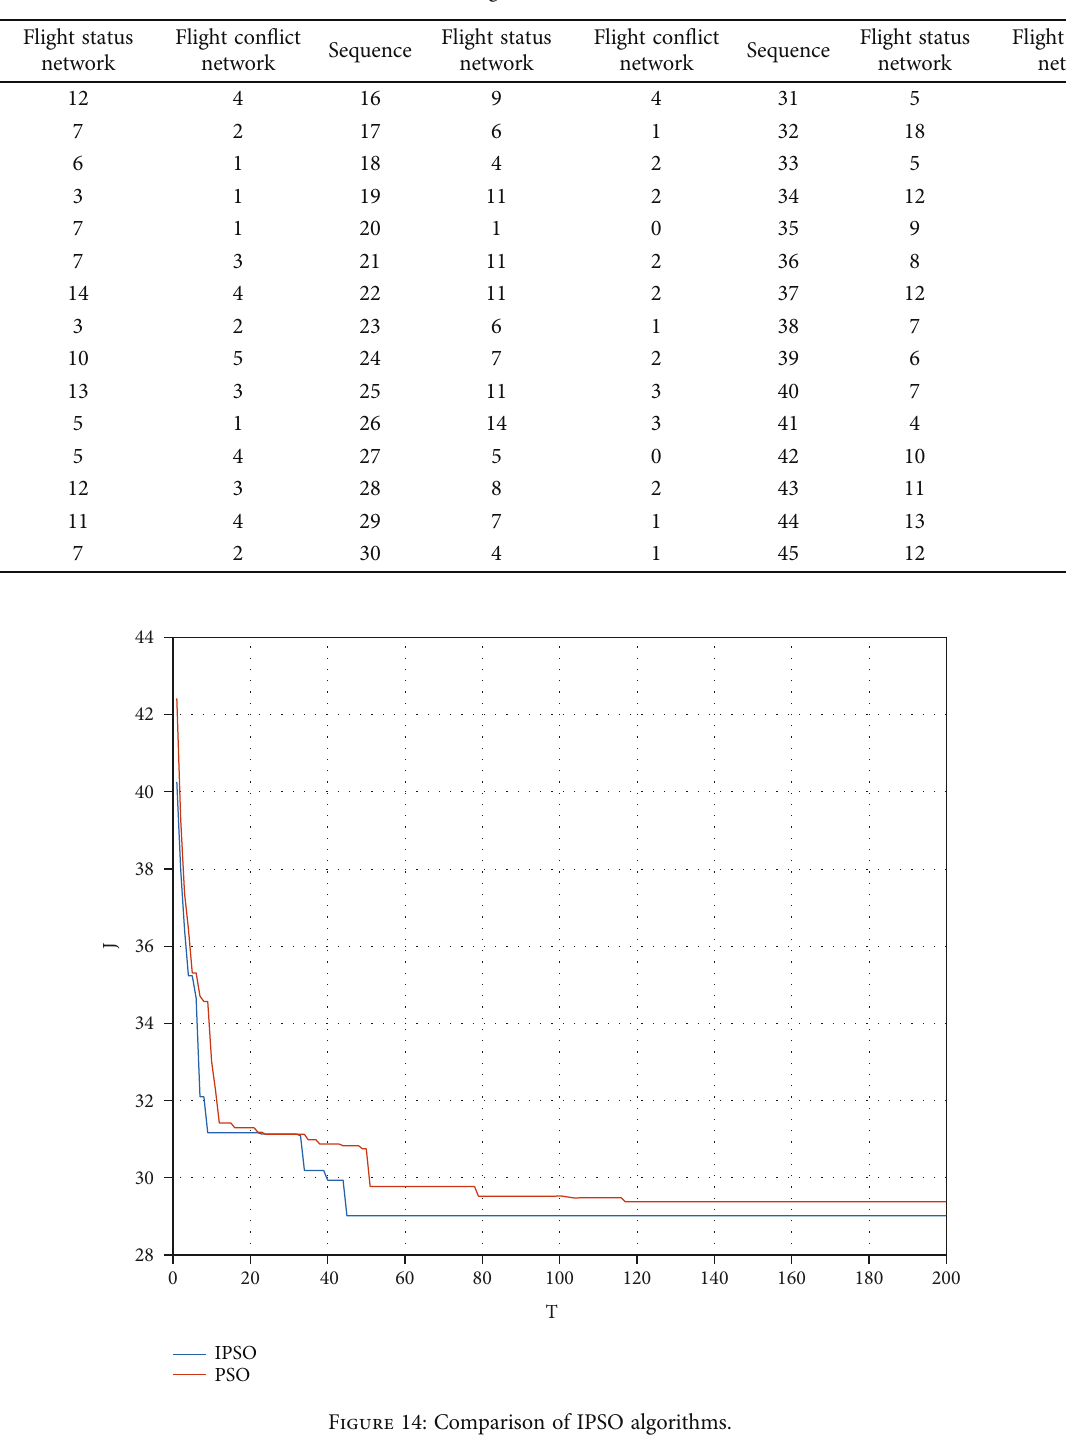
Table 1: Node degrees in di ff erent networks.